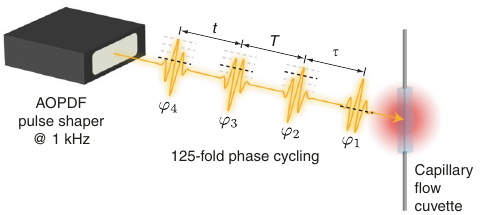
Fig. 1 Scheme of the experiment. An acousto-optic programmable dispersive fi lter (AOPDF) creates a phase-coherent pulse sequence with individual pulse phases φ i ( i = 1, 2, 3, 4) that is employed in the multidimensional experiment. Besides scanning the interpulse delays τ , T , and t , we further sample the phases of the second, third, and fourth pulse fi ve times each and fi nally detect the integrated fl uorescence intensity from the sample as a function of these excitation pulse sequence parameters